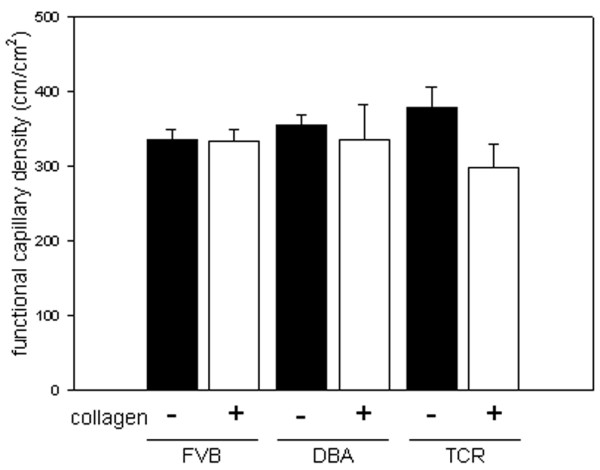
Functional capillary density. Shown is the functional capillary density of the synovium in complete Freund's adjuvant (CFA)/collagen II exposed FVB/NJ, DBA1/J and T-cell receptor (TCR) transgenic mice (collagen +) in comparison with CFA treated controls (collagen -). Intravital fluorescence microscopy of the knee joints was performed at 6 weeks after collagen exposure for induction of arthritis. Values are expressed as means ± standard error (n = 5–10 animals/group).